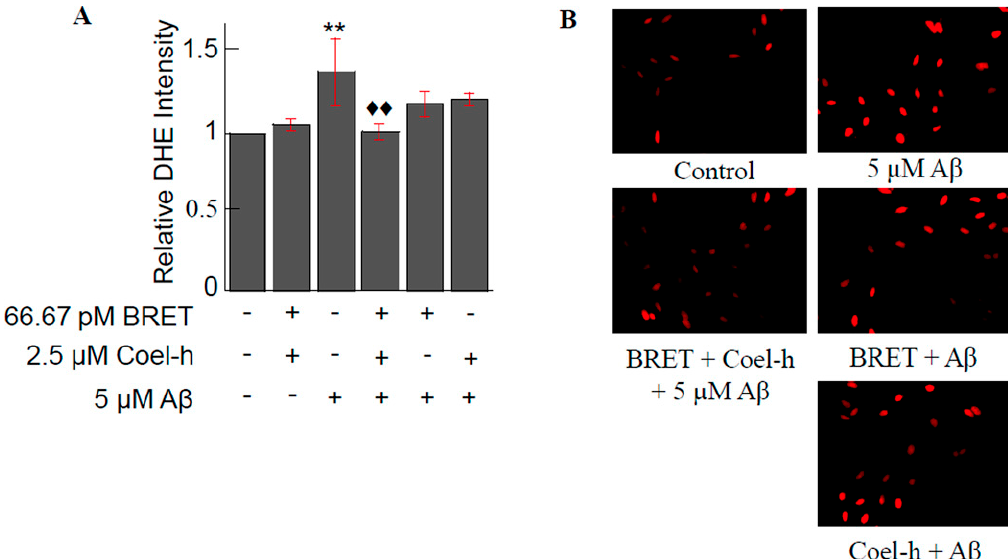
Figure 8. BRET-QD with coel-h pretreatment on A β -induced superoxide anions production. ( A ) A β treatment increased the fluorescent intensity of DHE by 40% as compared to control. The pretreatment of BRET-QD (66.7 pM) and coel-h (2.5 µ M) suppressed the A β -induced increase in superoxide anion production back to that of control. Both the BRET-QD and Coel-h alone pretreatment lowered A β -induced superoxide anion, but not with a statistical significance. ( B ) Fluorescence images representing each experimental group. Each experiment was repeated three timesas compared to 5 µ M A β . Data of each treatment group were normalized by the control for each independent experiment prior to statistical analysis. Reprinted from [92], with permission from Elsevier.